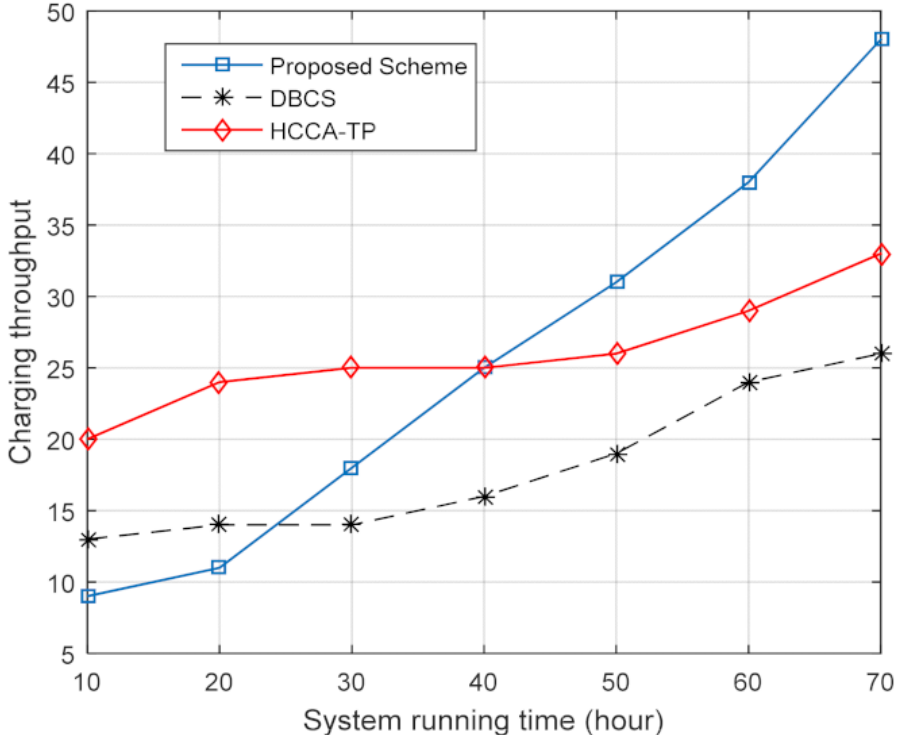
Figure 3. Comparing the charging throughputs of the various